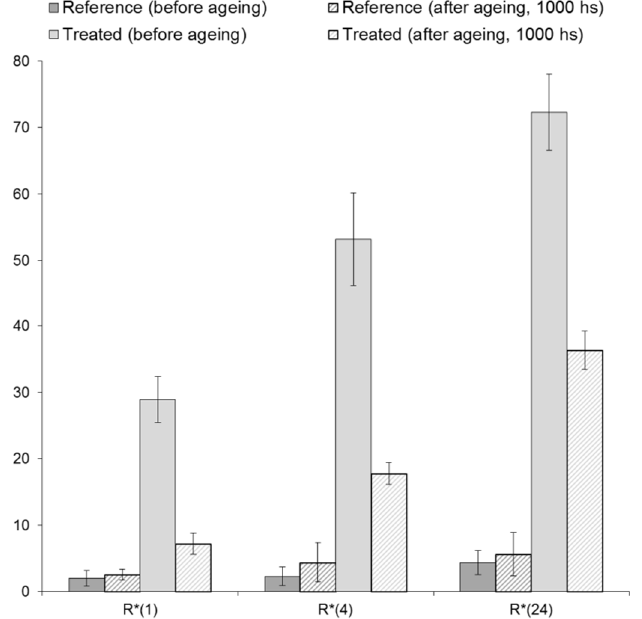
Figure 4. Average values of the parameter R * describing the intensity of self-cleaning E efficiency during test procedure (after 1, 4 and 24 h of exposure to UV light) on treated and untreated surfaces. The results refer to the performances measured at time zero (before ageing) and at the end of the 1000 h-long weathering procedure (after